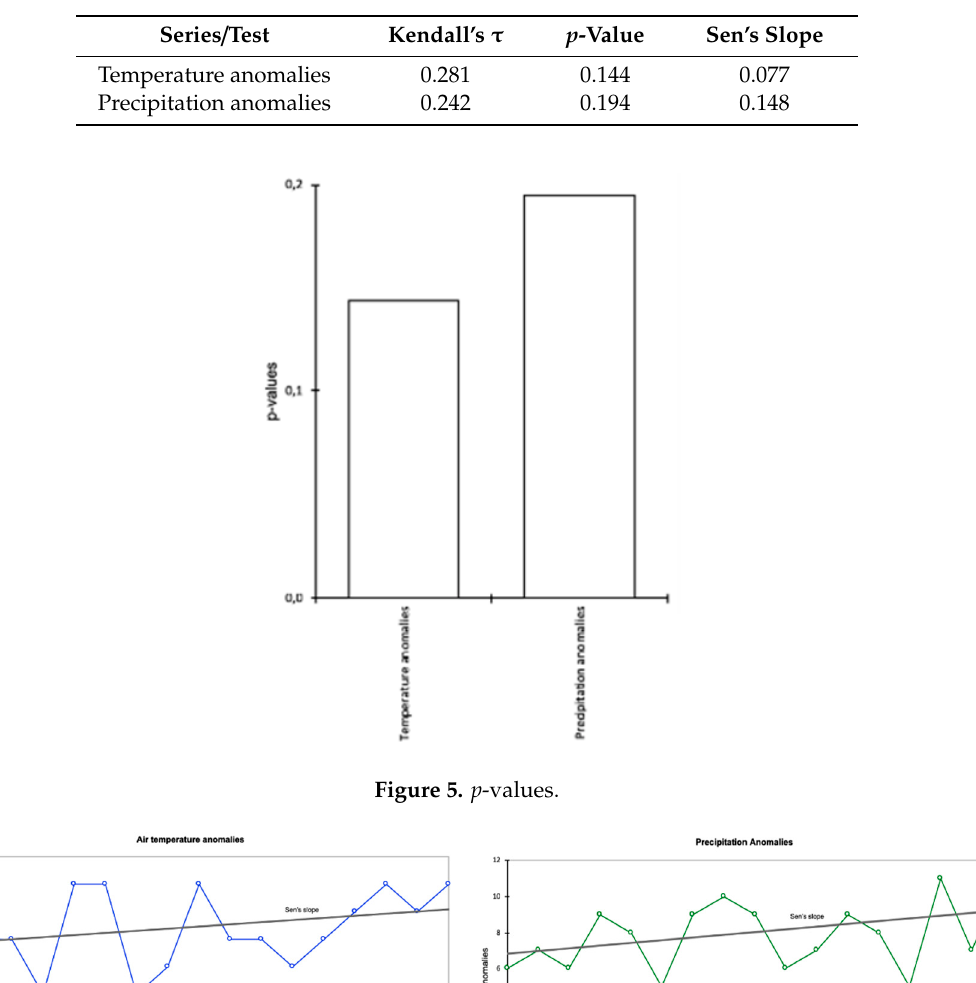
Figure 6. Sen’s slope indicating the increasing probability for the occurrence of anomalies. As can be seen in the figures, the Sen’s slope indicates an increasing trend for the occurrence of anomalies, allowing it to be inferred that, over the years, an increasing number of anomalies can be expected to occur.